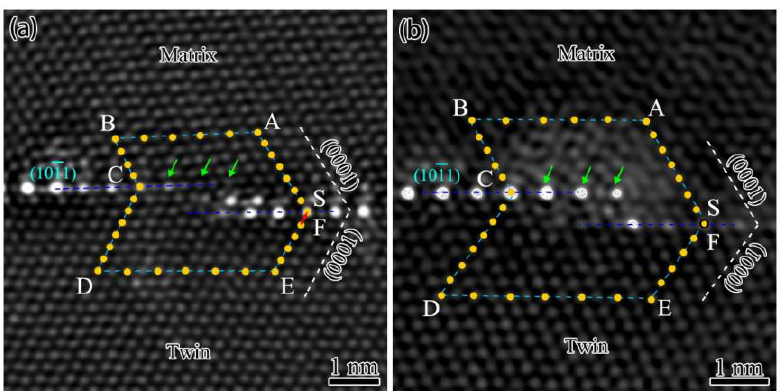
Figure 3. Atomic-scale HAADF-STEM images of micro-step I in [12 ̅ 10] zone axis marked with a Burgers circuit: ( a ) A micro-step with misfit dislocation, and ( b ) a micro-step free of dislocation.